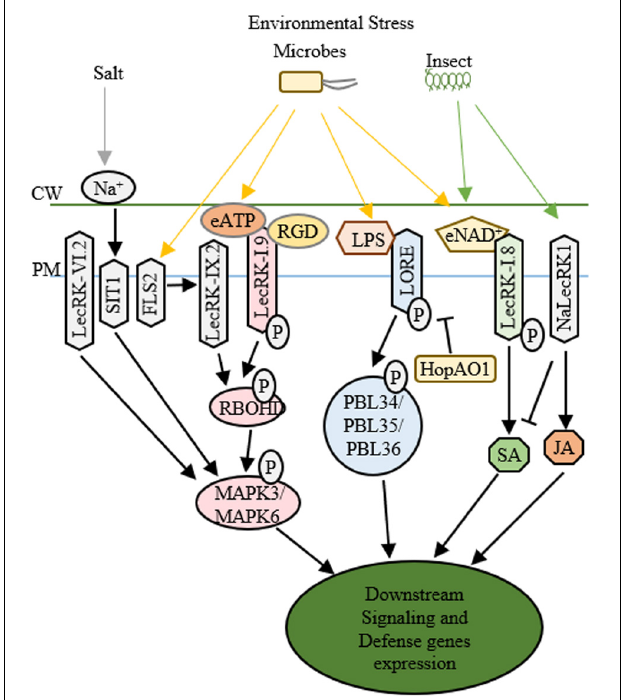
FIGURE 2 | Functions of LecRLKs in plant stress responses. Environmental factors from abiotic and biotic stresses could be perceived by LecRLKs located at the plasma membrane, which can transduce the signal and trigger plant defense and stress responses. LecRK-IX.2 might serve as the downstream of FLS2. After it is activated, LecRK-IX.2 can phosphorylate RBOHD which then phosphorylates MAPK3/MAPK6 triggering defense genes expression. LecRK-I.9 could recognize external ATP (eATP) which then activates its autophosphorylation and kinase activity, causing the phosphorylation of RBOHD and MAPK3/MAPK6. The tripeptide Arg-Gly-Asp (RGD) ligand of IPI-O, a Phytophthora infestans effector, could be recognized by LecRK-I.9, which then disrupts its function in cell wall-plasma membrane adhesions and plant defense. SIT1 and LecRK-VI.2 can also activate MAPK3/MAPK6, while SIT1 is activated under salt stress, LecRK-VI.2 is involved in plant defense against several bacterial pathogens. After